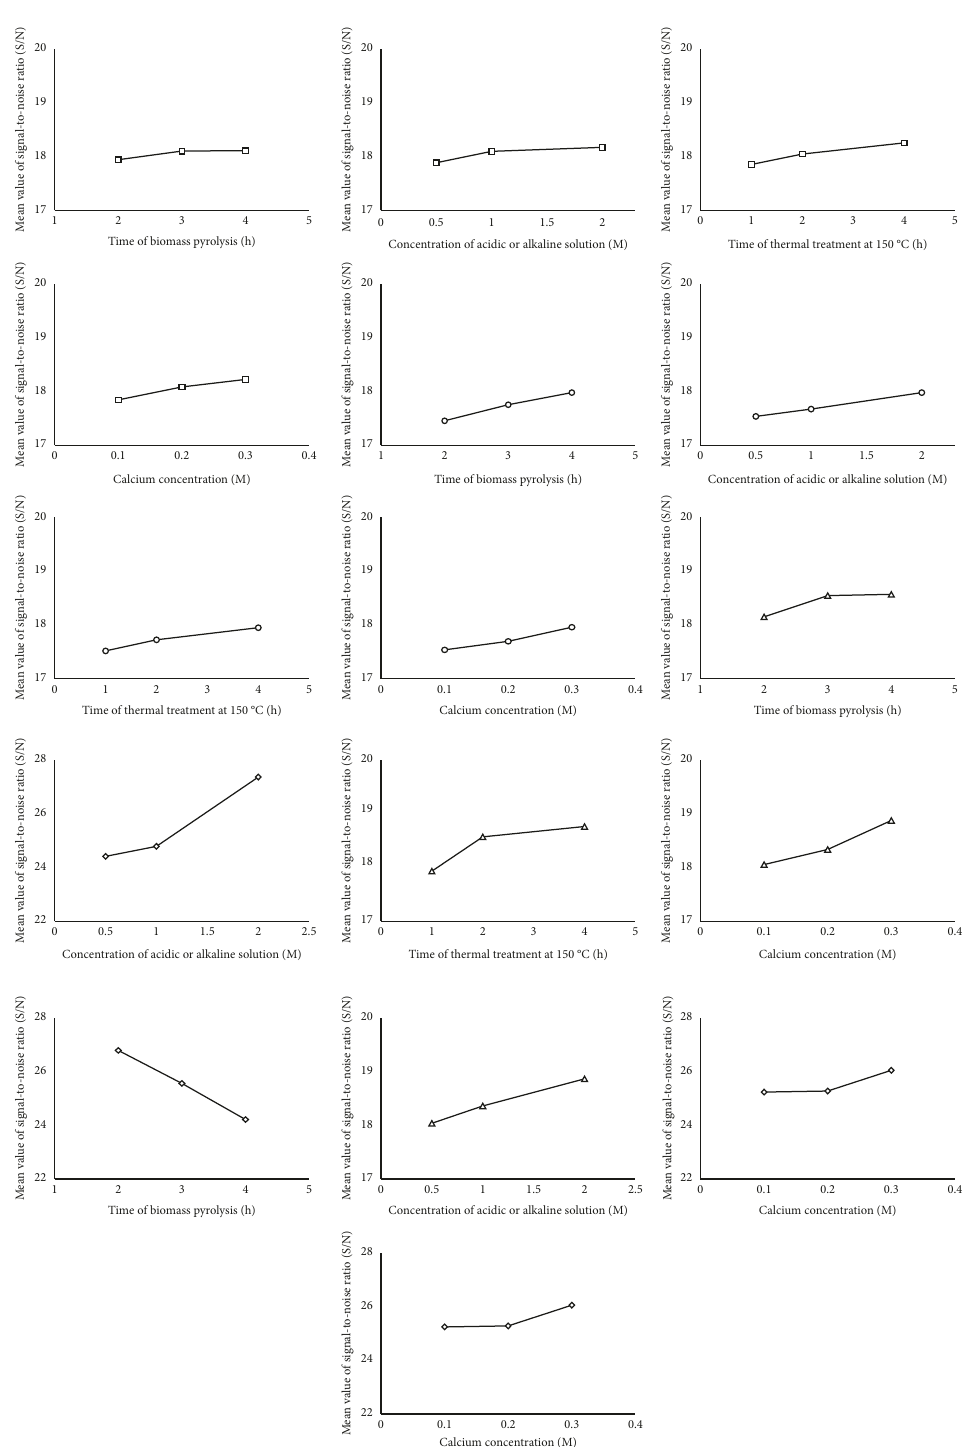
Figure 3: The S/N ratio for the preparation conditions of alkaline and acidic heterogeneous catalysts using ( □ ) citric acid (CA), ( ○ ) tartaric acid (TA), ( Δ ) sulfuric acid (SA), and ( ◊ ) potassium hydroxide